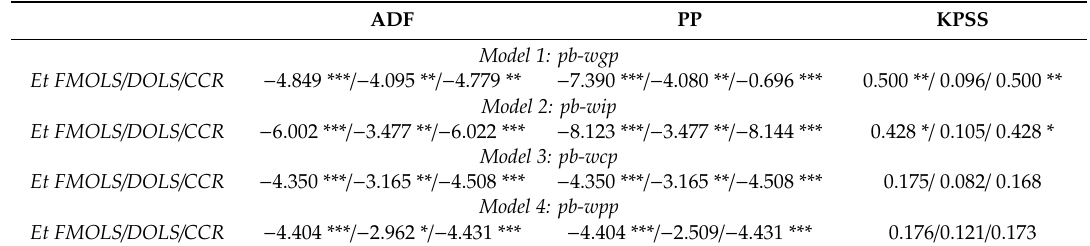
Table A18. W. The Unit Root test results (ect).